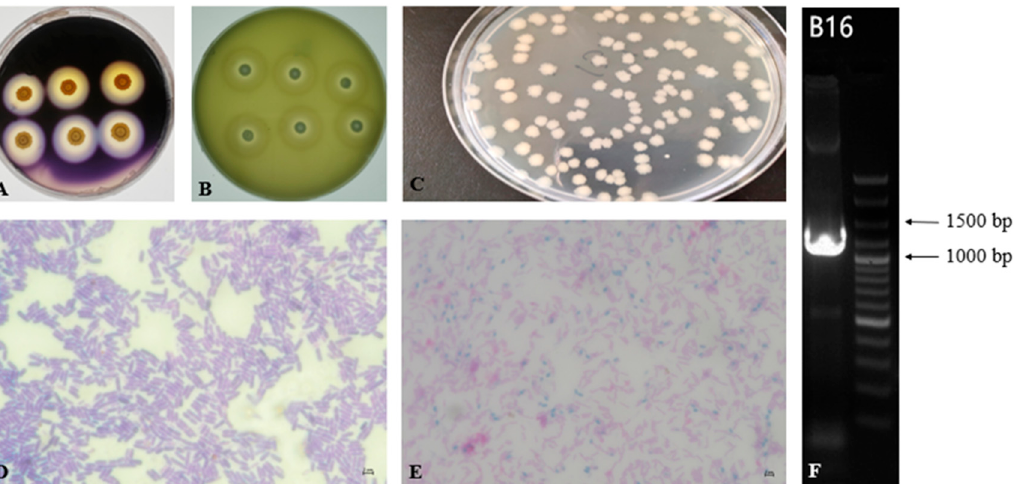
Figure 2. The shapes of strain B16 (Bacillus. velezensis) and the result of the 16S rDNA agarose gel electrophoresis. Hydrolysis circle of amylase ( A ) and protease ( B ) secreted by B. velezensis ; ( C ): colony morphology of B. velezensis observed directly; ( D , E ): microscope observation of B. velezensis after staining; ( F ): the result of 16S rDNA agarose gel electrophoresis of B. velezensis . The sequence 16S rDNA gene of strain B16 was 1351 bp (Figure 2F). The 16S rDNA sequence was deposited in NCBI GenBank with the accession Bacillus. velezensis (MT649755.1), B. siamensis (MT645306.1), B. velezensis (CP054714.1), B. amyloliquefaciens